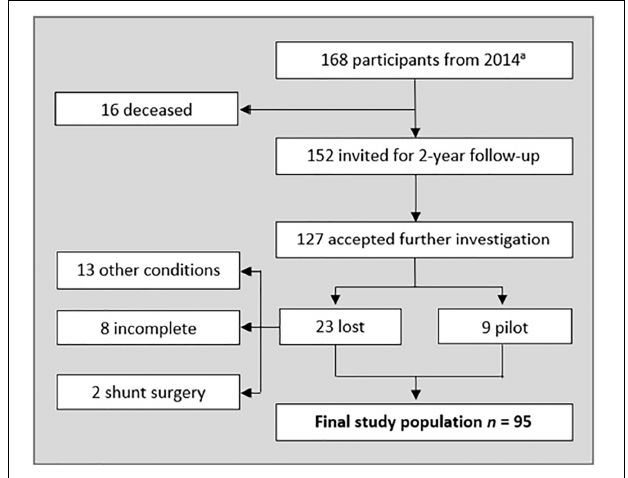
FIGURE 1 | Flow-chart representing included participants. a see Andersson et al., 2019. Other conditions severely affecting gait and/or cognition was excluded from the sample (Alzheimer’s disease, hip-surgery, cancer, visual impairment, spinal stenosis, and secondary hydrocephalus. Five of them failed the dual task, and three used walking aid). Three declined neurological examination, three had incomplete neuropsychological tests, and two declined imaging. Two participants had been given a shunt after the 2014 study. Nine randomly picked participants (all diagnosed with Unlikely iNPH) were given a pilot test protocol. The number of pilots needed was based on when the test protocol was fulfilling the aim of the